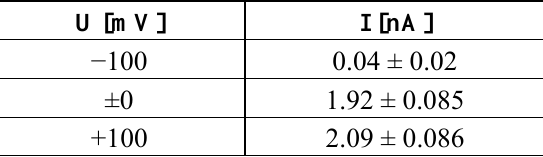
Table 1. Amperometrical response after addition of 1 mM lactose at different potentials applied to